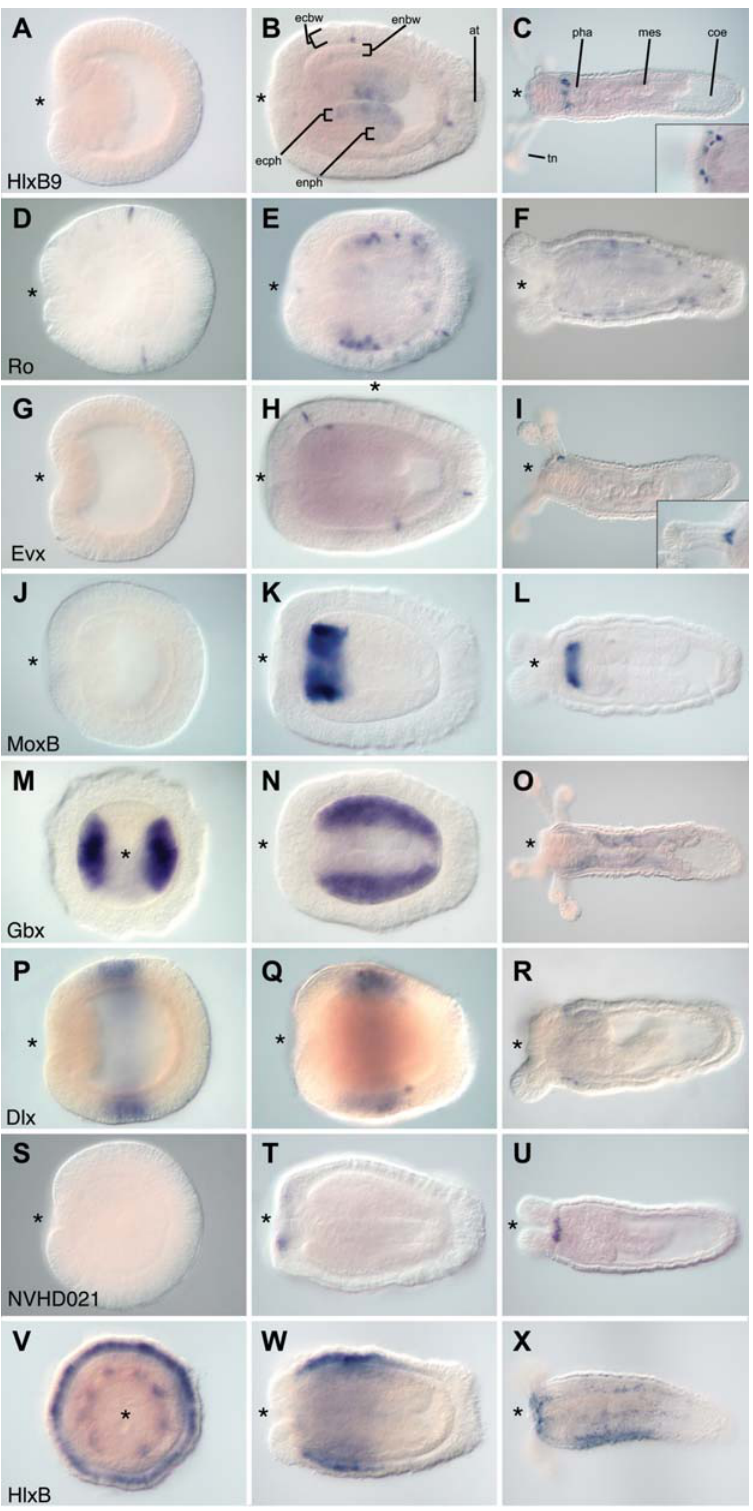
Figure 4. Developmental Expression of Hox-ParaHox related genes in Nematostella . Gene expression was assayed throughout embryonic and larval development using in situ hybridization. All images are optical sections that permit visualization of the endodermal tissue layer. Panels M and V are transverse sections, but all other images are longitudinal sections with the future oral end of the animal facing left. The blastopore (site of the future mouth) is indicated by an asterisk. Abbreviations are as follows: apical tuft (at); coelenterone (coe); bodywall ectoderm (ecbw); pharyngeal ectoderm (ecph); bodywall endoderm (enbw); pharyngeal endoderm (enph); mesentery (mes); pharynx (pha); tentacle (tn).